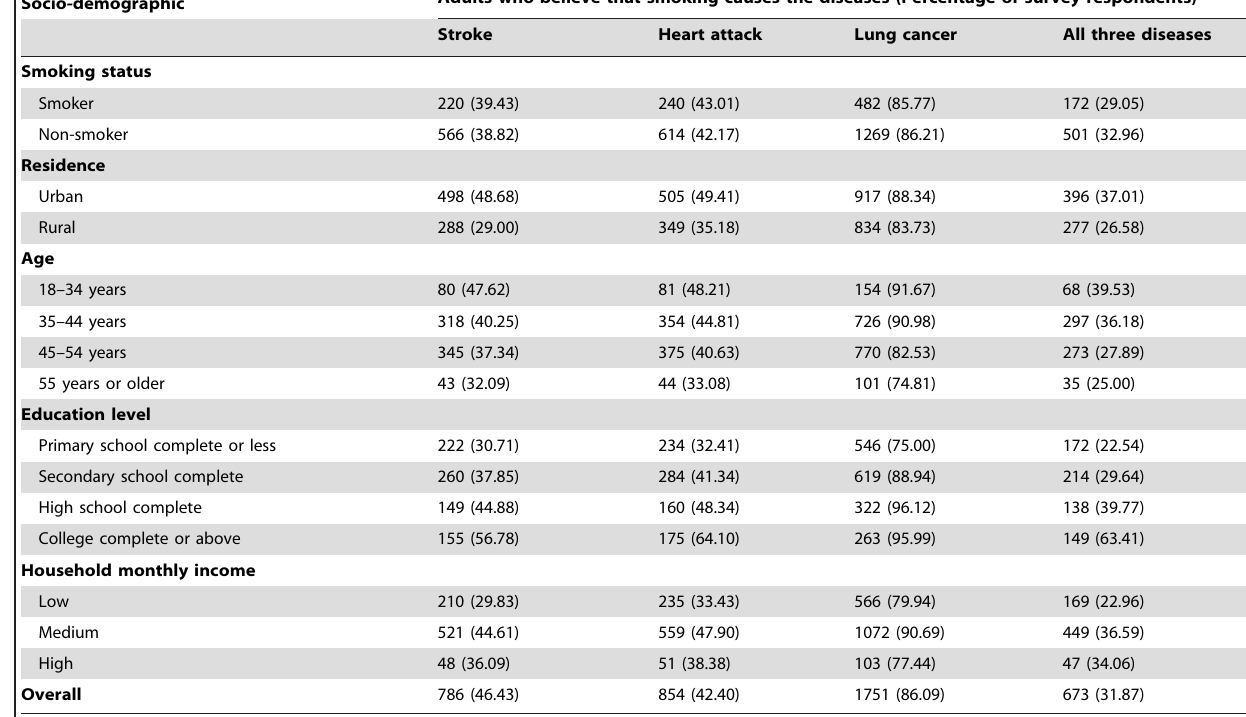
Table 1. Percentage of respondents with knowledge of tobacco-related disease.